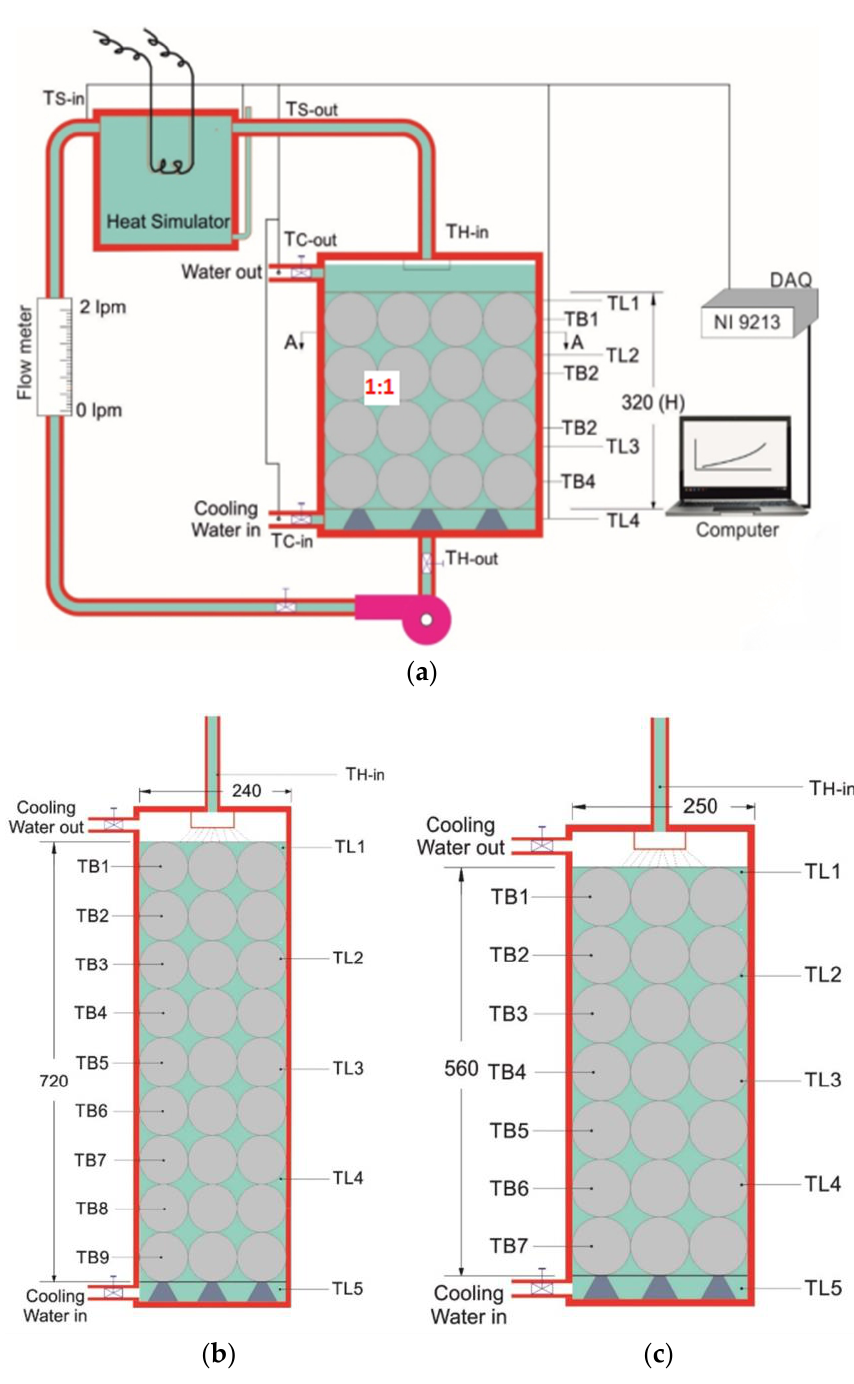
Figure 10. The layout of the storage tanks with an aspect ratio of ( a ) 1:1, ( b ) 3:1, and ( c ) 2:1 [35].